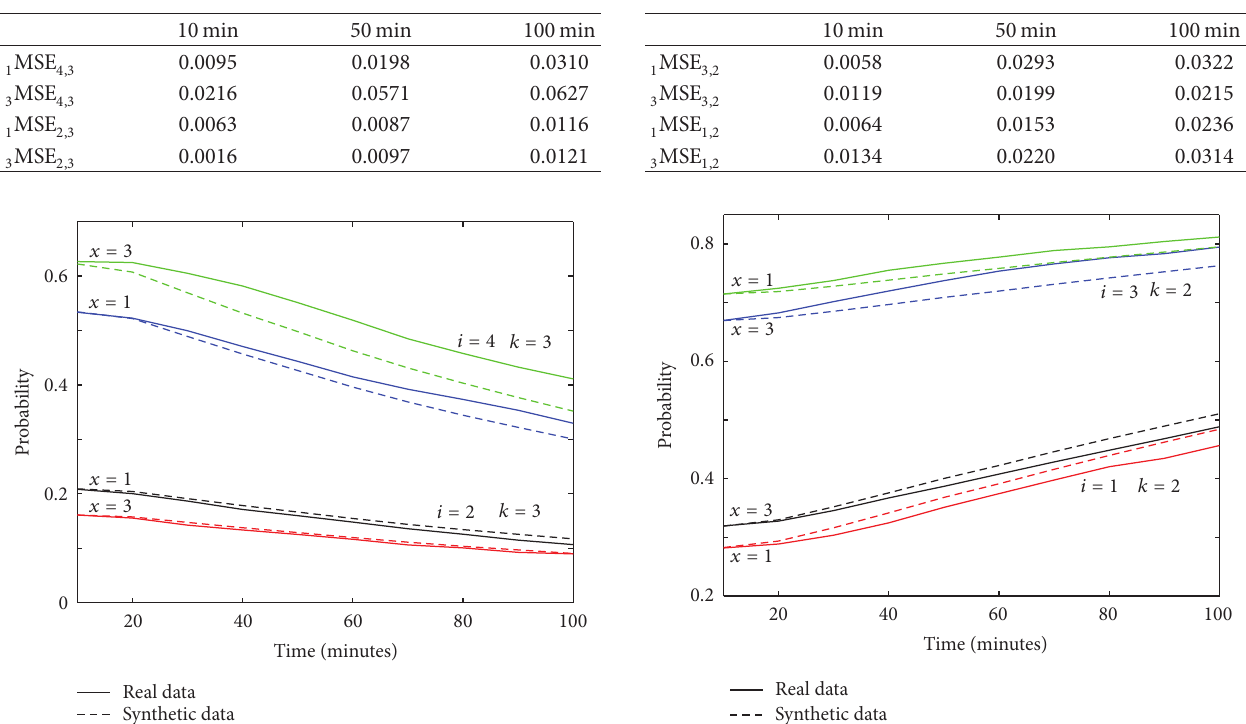
T 4: Mean square error between the curves of the maintainabil- ity applied to real and synthetic data.